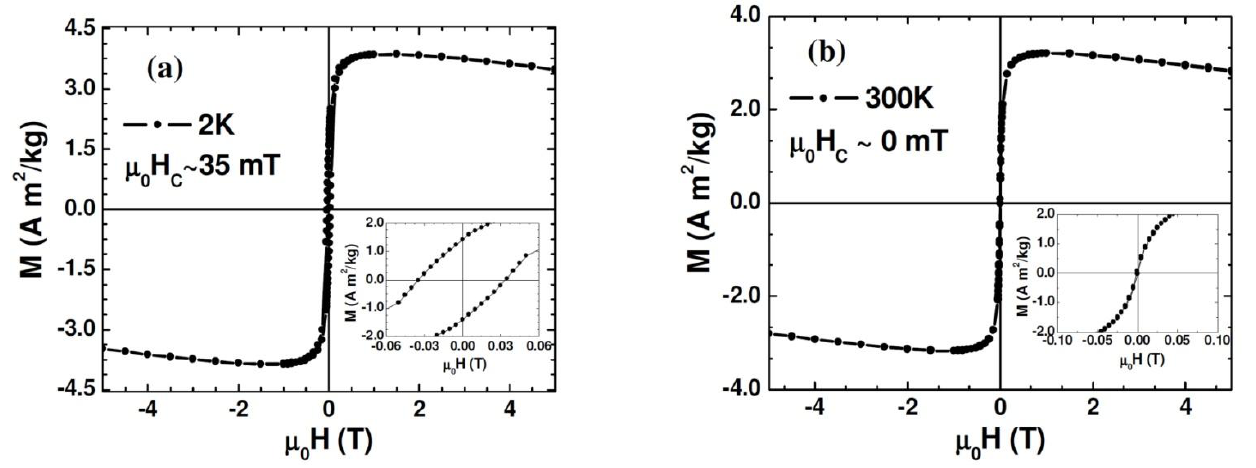
Figure 3. Magnetization versus magnetic field (M-H) curves taken at 2 K ( a ) and 300 K ( b ) for Au-Fe O 3 4